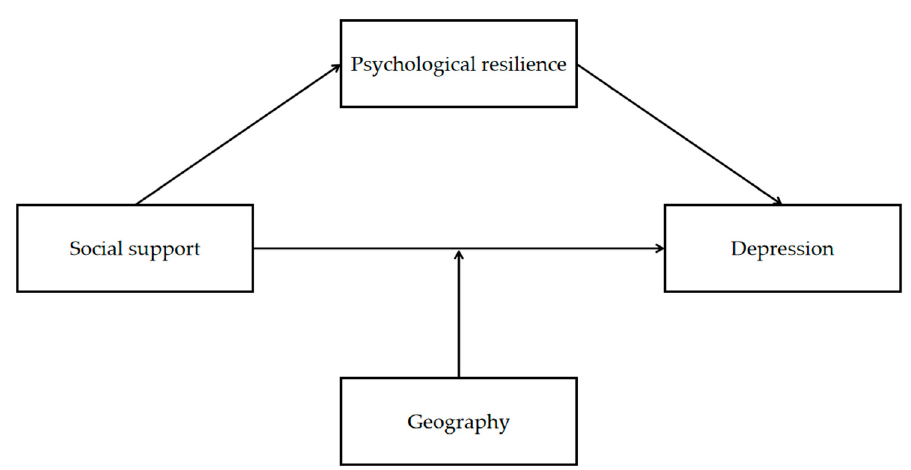
Figure 1. The constructed moderated mediating model.